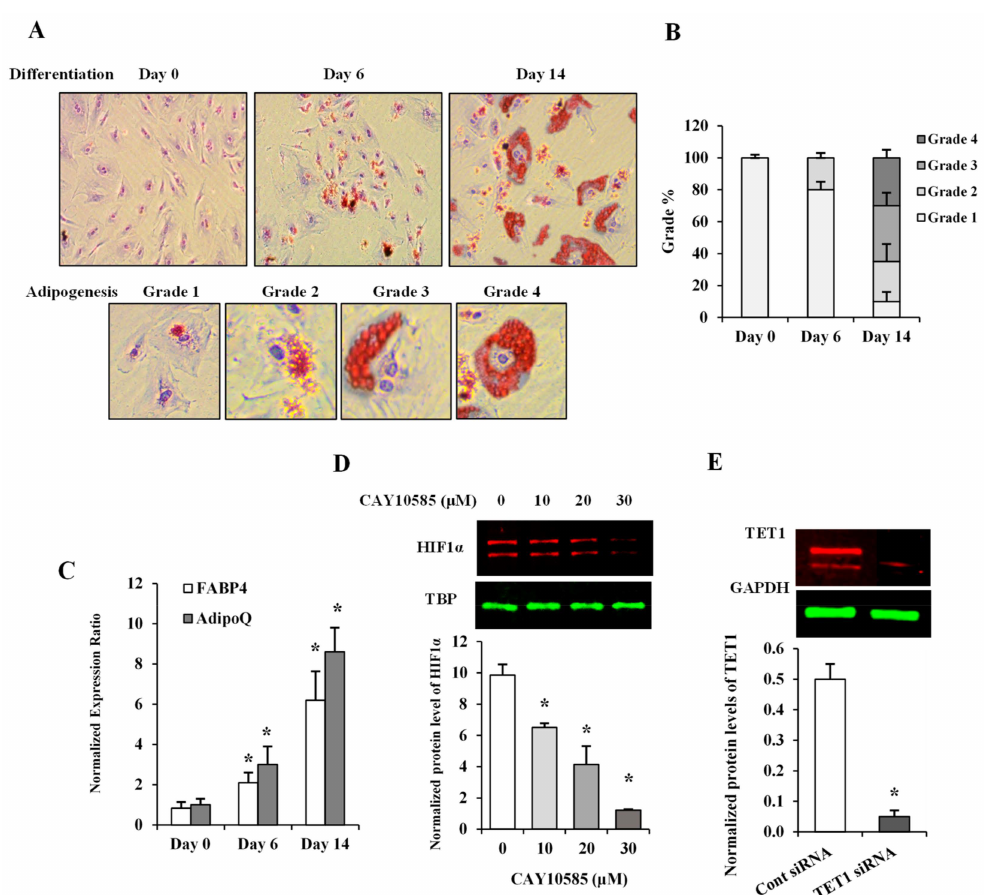
Figure 1. Assessment of adipocyte di ff erentiation and HIF1 α and TET1 inhibition in di ff erentiated adipocytes. ( A ) Microscopic grading of adipocyte di ff erentiation based on cytoplasmic accumulation of lipid droplets by di ff erentiation days 0, 6, and 14 (upper panel; original magnification 10X). Representative images of individual cells with varying degrees of lipid accumulation that reflect di ff erent grades of adipogenesis (lower panel; original magnification 20X). ( B ) A stacked column